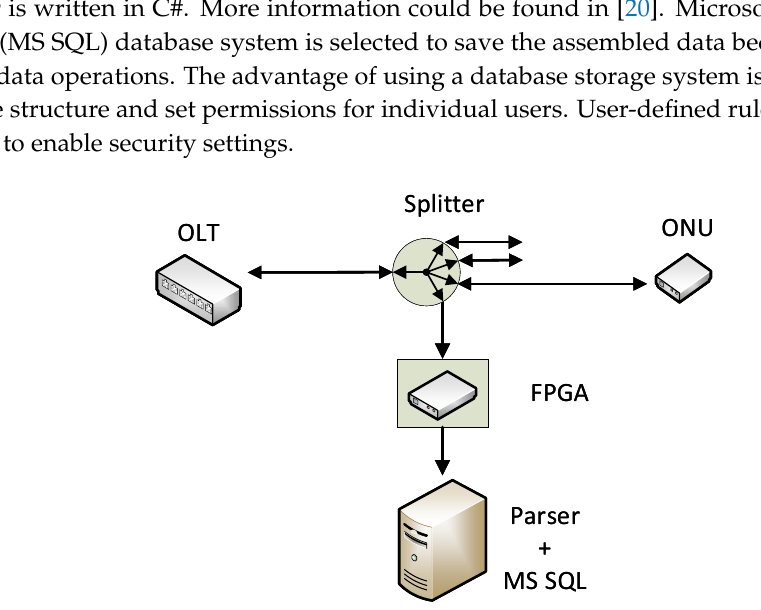
Figure 4. The block diagram of our